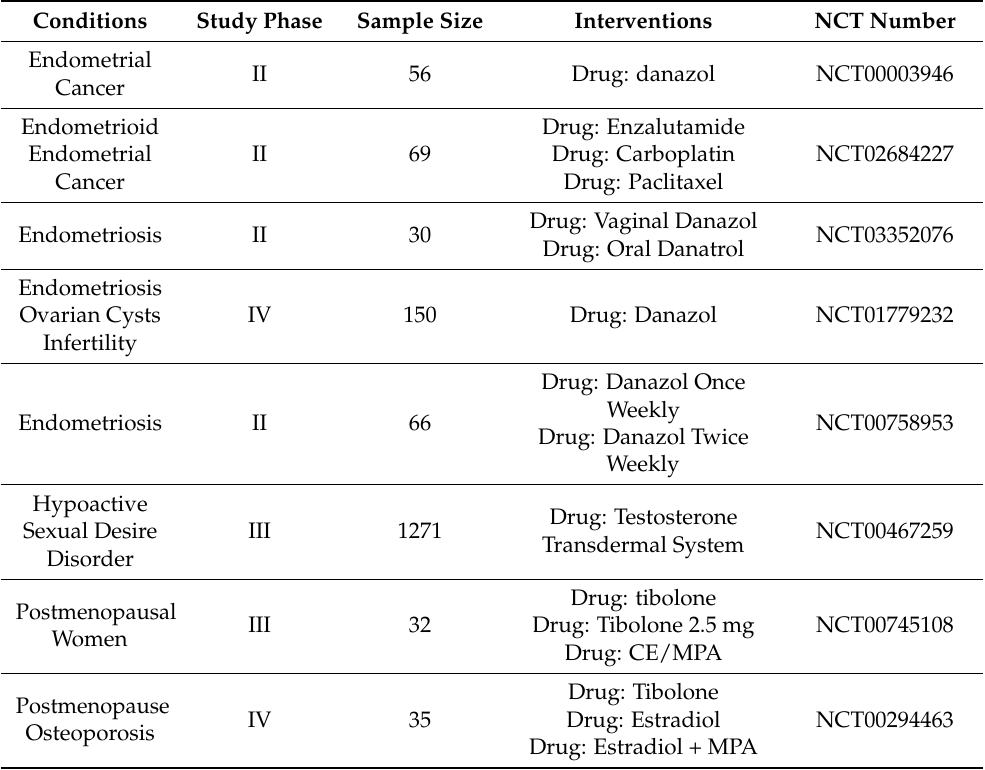
Table 1. Ongoing studies testing androgen-related therapies in uterine